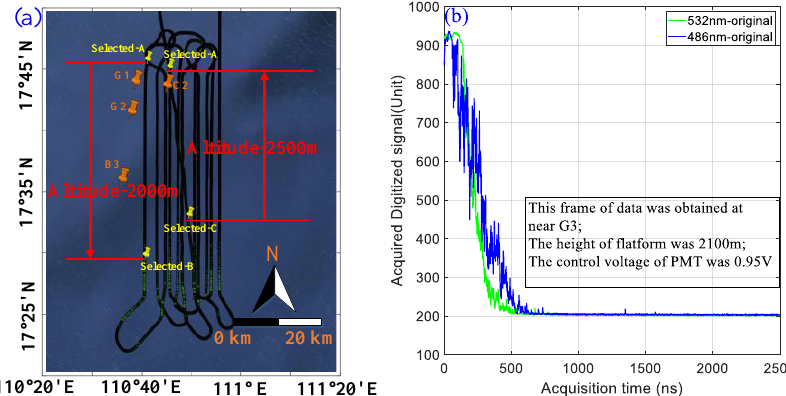
Figure 13. ( a ) Position of selected data; ( b ) one frame of data from the selected dataset.